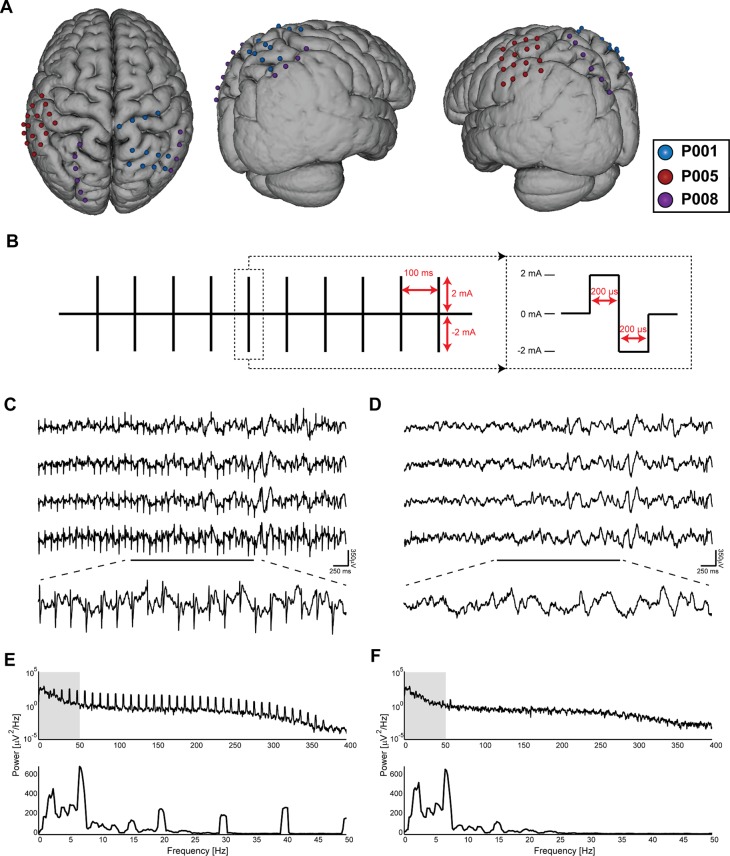
Electrode Locations and Artifact Suppression.(A) Surface model of an atlas brain showing locations of electrodes over the parietal regions in each of the three patients. Signals measured from only these electrodes were used in the analysis. Refer to S2 Fig for the stimulation electrodes and electrodes over other regions. (B) Schematic of stimulation waveform used. Stimulation consisted of one biphasic pulse 400 μs in duration every 100 ms for 5 s. (C) Stimulation artifacts in representative sample traces from four electrodes (top). Enlarged portion denoted by the black line (bottom). Artifacts appear as periodic sharp deflections with stereotyped waveforms. (D) Traces from the same four electrodes as in (B) after the artifact suppression procedure. The artifacts are suppressed compared to the signal amplitude. (E) Spectrum of the fourth waveform in (B) showing peaks at 10 Hz and harmonics of 10 Hz corresponding to artifact waveform. Top: Full frequency range. Bottom: Zoom-in on low frequencies. (F) Spectra of the same waveform after artifact suppression confirming the effectiveness of the algorithm. The only remaining exogenous peak is at 60 Hz, caused by electric line noise.